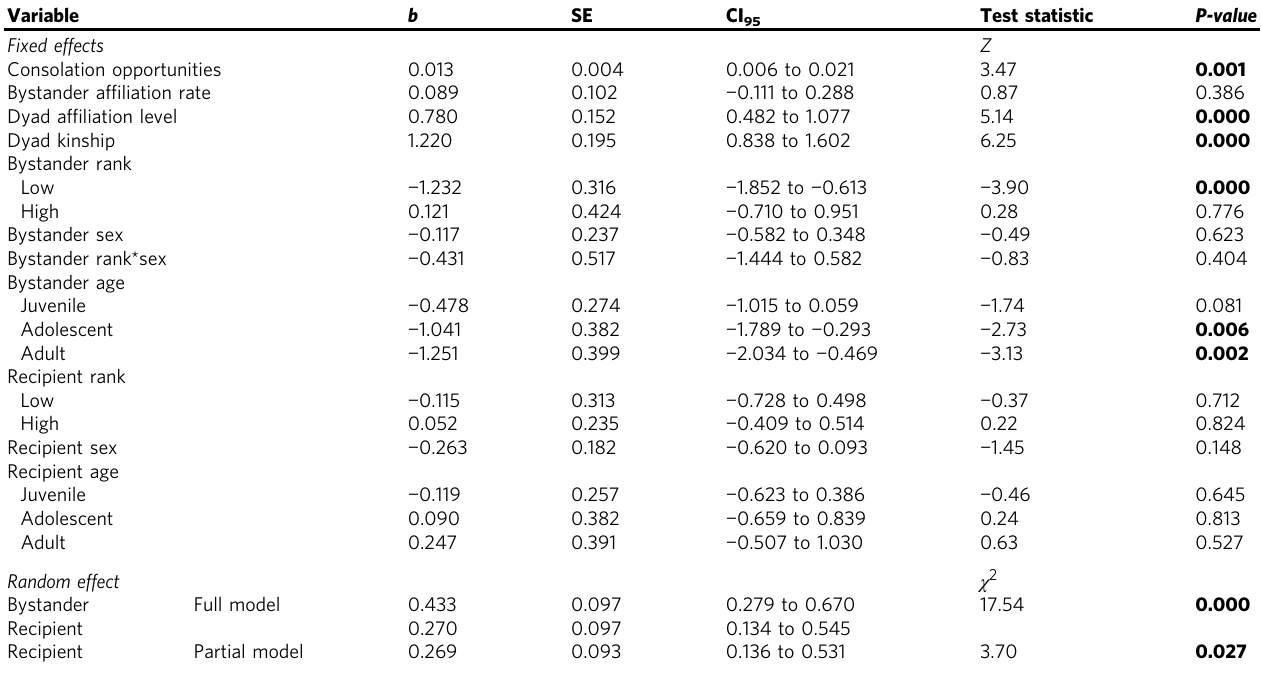
Table 1 Results of GLMM testing for individual differences in consolation Variable